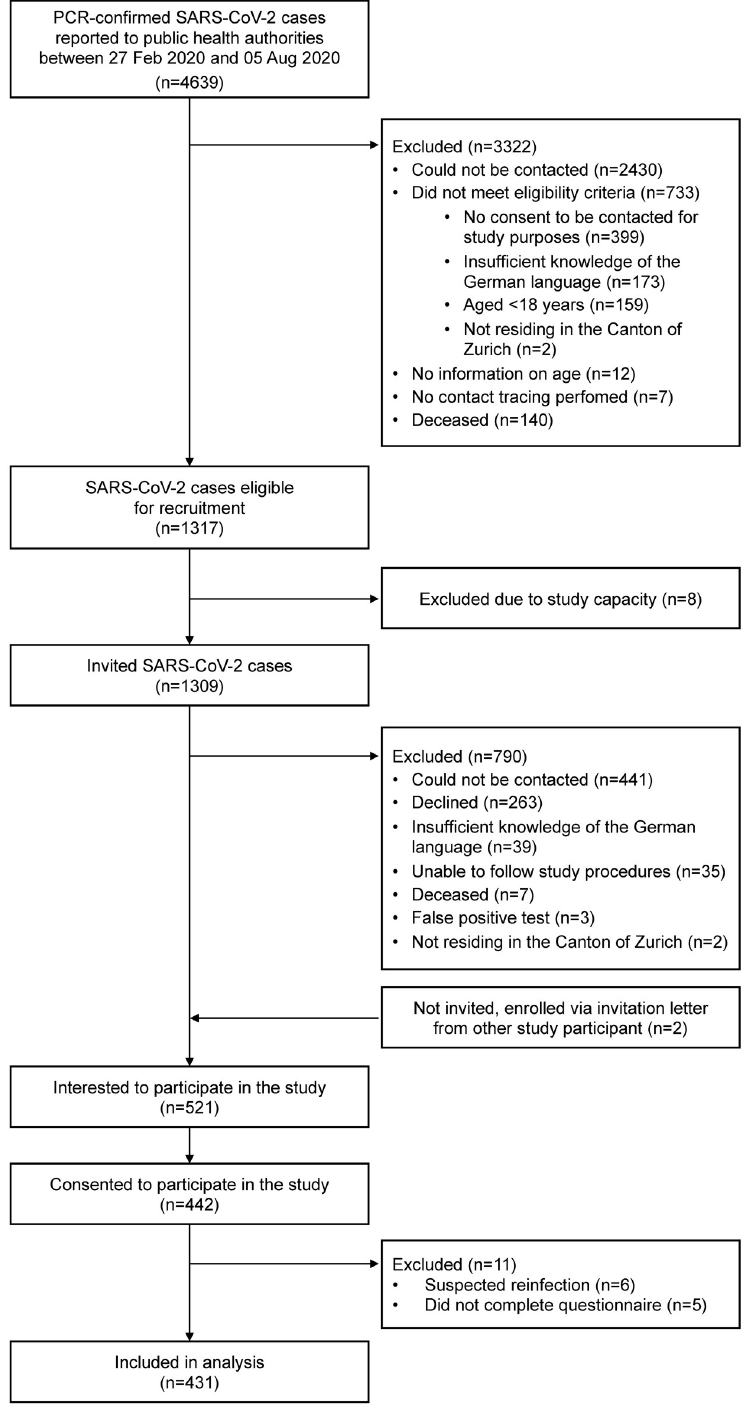
Fig 1. Flow chart for the inclusion of SARS-CoV-2 infected individuals from the Canton of Zurich, diagnosed between 27 February 2020 and 05 August 2020.